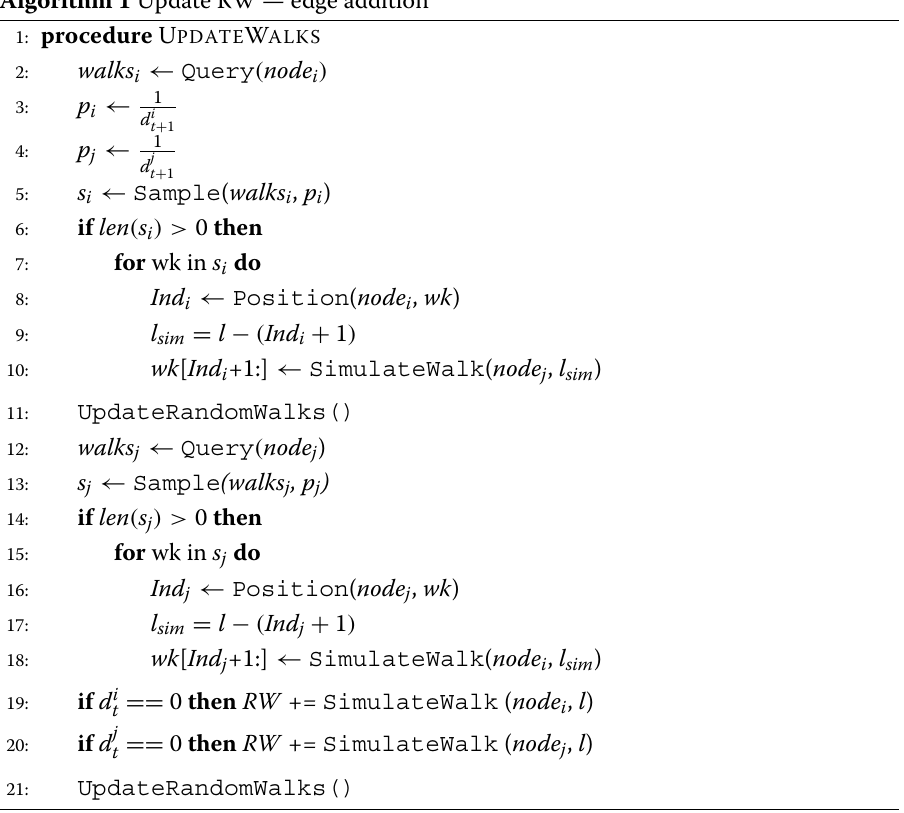
Algorithm 1 Update RW — edge